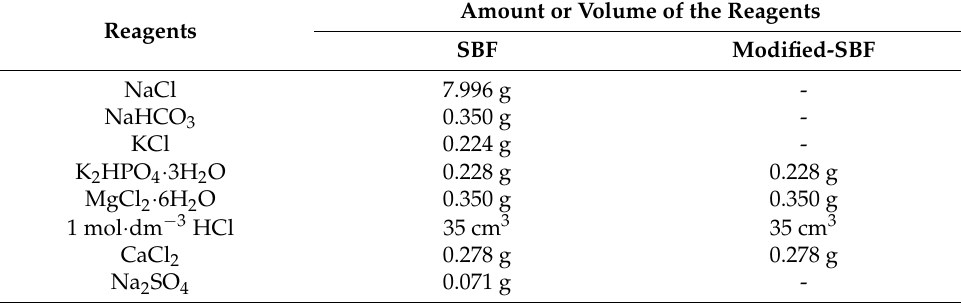
Table 2. Amount or volume of dissolved reagents in the preparation of 1 dm 3 of SBF [17] and